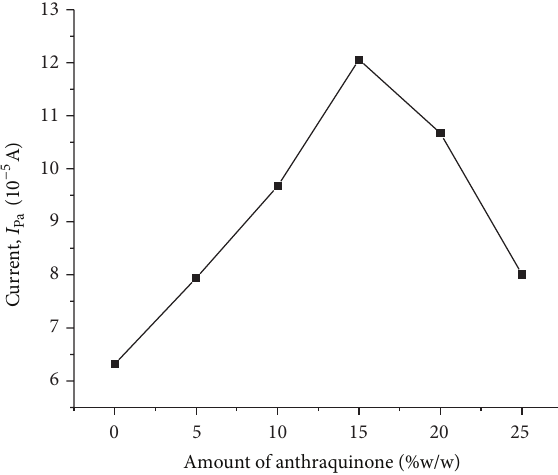
Figure 3: Effects of variation of pH on the anodic potential of 1mM caffeine.